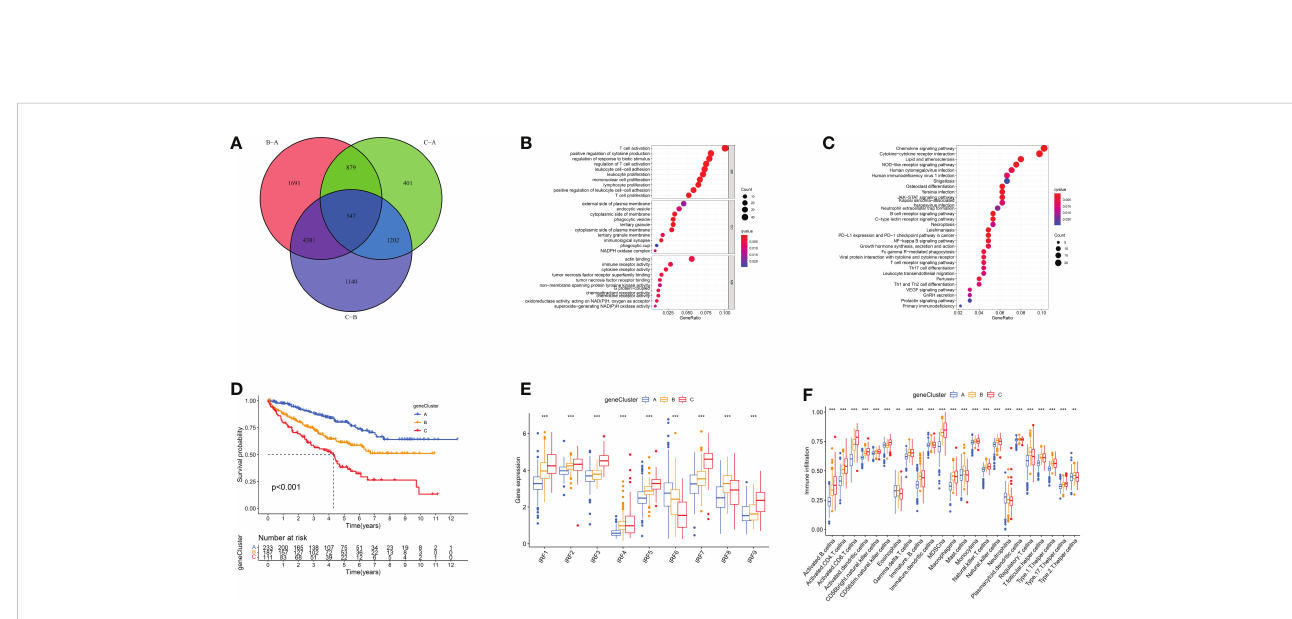
FIGURE 4 IRF gene clusters in ccRCC and biological characteristics of each gene cluster. (A) 547 IRF-associated DEGs shown in venn diagram. (B-C) GO (B) and KEGG (C) enrichment analysis on these DEGs. (D) Survival analyses of three IRF gene clusters. (E) The expression of IRFs in three gene clusters. (F) The abundance of each TME in fi ltrating cell in three gene clusters. **p < 0.01; ***p <